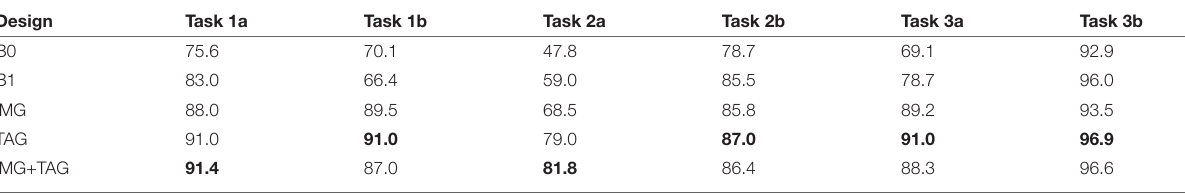
The bold value indicates the largest values per column.